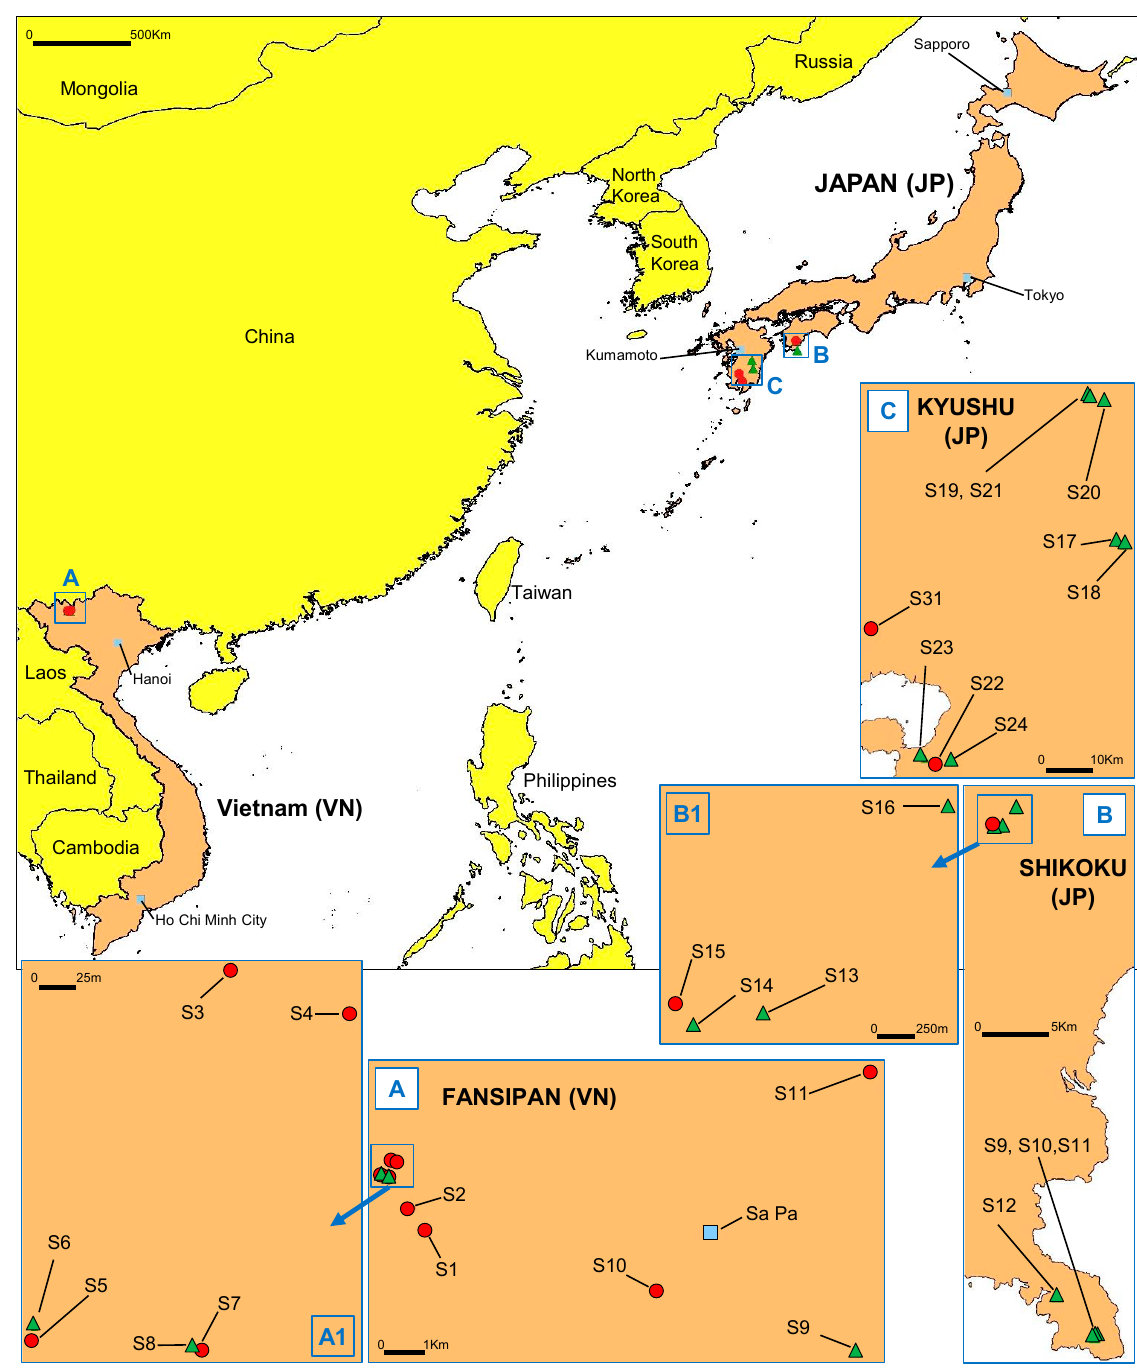
Figure 1. Location of areas and stream catchments (S) sampled in Vietnam and Japan. ( A ) Fansipan (VN-S1 to VN-S10) and Sau-Chua (VN-S11) areas in northern Vietnam close to the Yunnan border. ( B ) Shikoku, Japan, Tosashimizu (JP-S9 to JP-S12) and Shimanto (JP-S13 to JP-S16) areas. ( C ) Kyushu, Japan, Aya (JP-S17, JP-S18), Shiba (JP-S19 to JP-S21), Tarumizu (JP-S22 to JP-S24) and Kirishima (JP-S31) areas. Red circles indicate sample sites with Phytophthora ramorum ; green triangles indicate sites where P. ramorum was not detected.